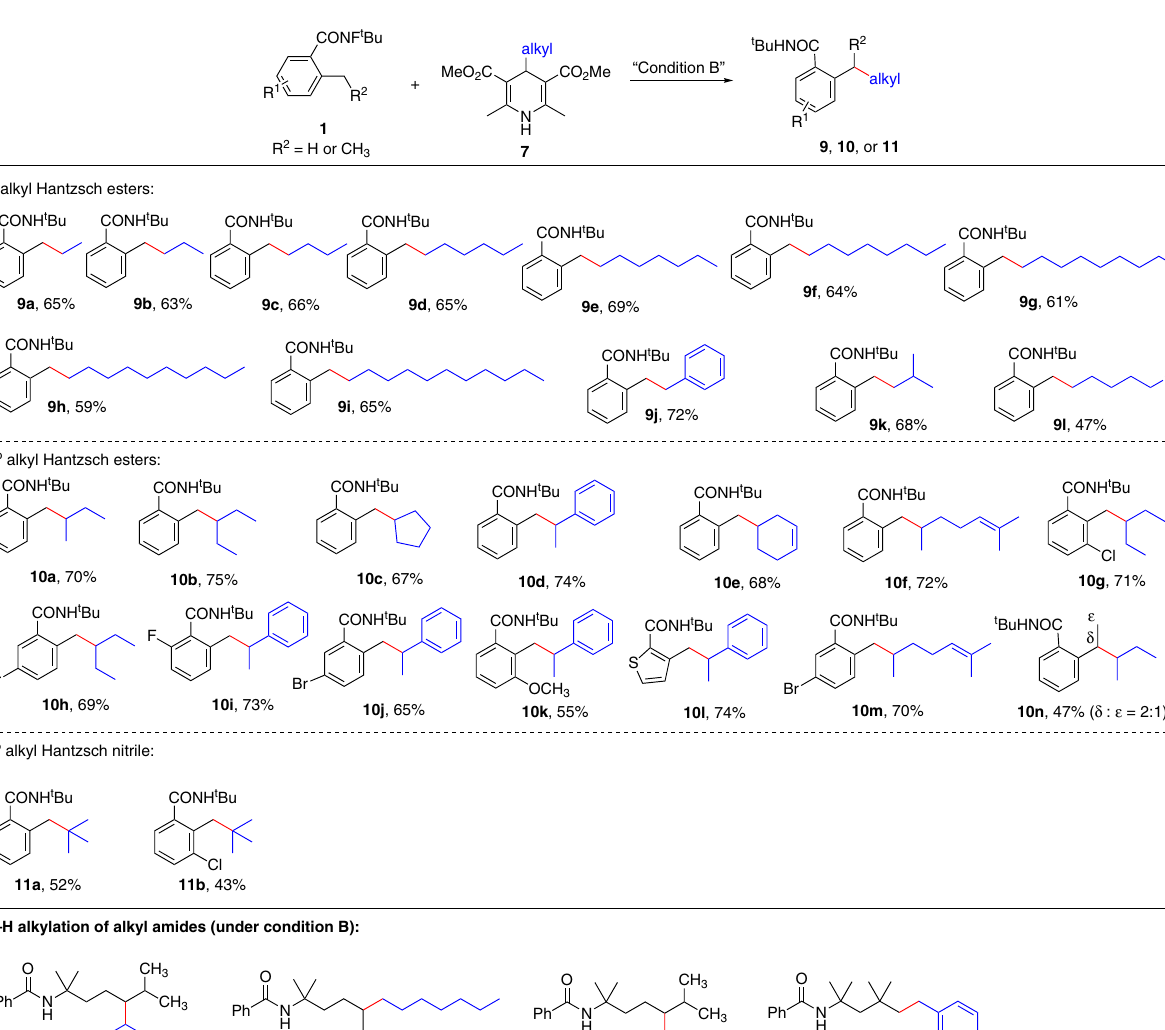
Fig. 5 Substrate scope of carboxylamides with cyclohexyl Hantzsch ester. All reactions were conducted in 0.2 mmol scale. Yields referred to isolated yields.